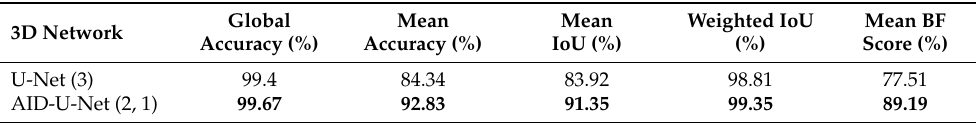
Table 7. Comparison between semantic segmentation results achieved by U-Net(3) and proposed AID-U-Net(2,1) for 3D brain tumor